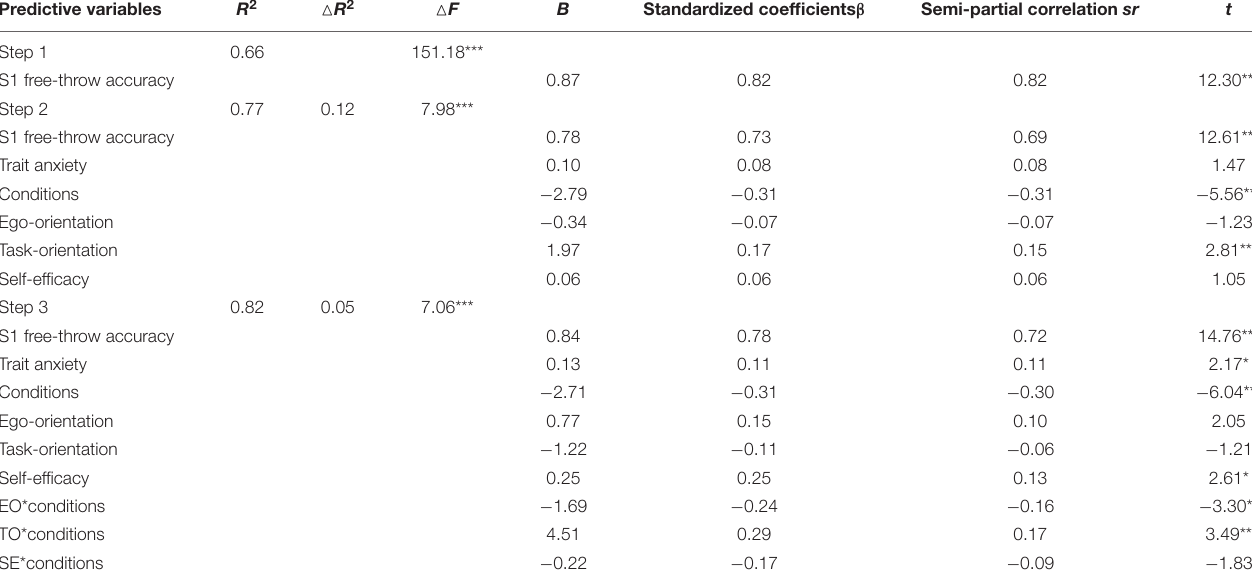
TABLE 2 | Regression analysis predicting free-throw competition (S2)